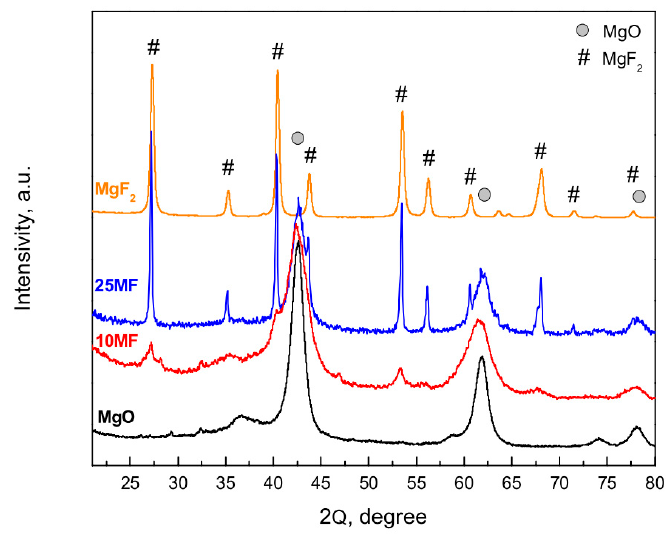
Figure 2. X-ray diffraction patterns of MgO, 10 MF, 25 MF, and MgF 2 samples heated at 500 °C.